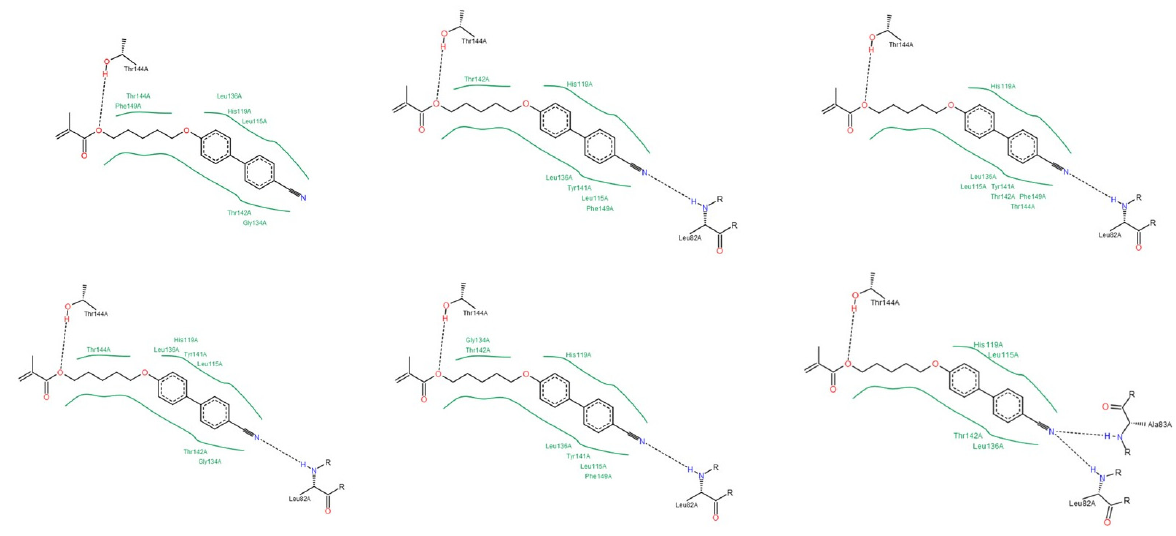
Figure A15. Interactions between compound B and MMPb-13, by PoseView calculations.